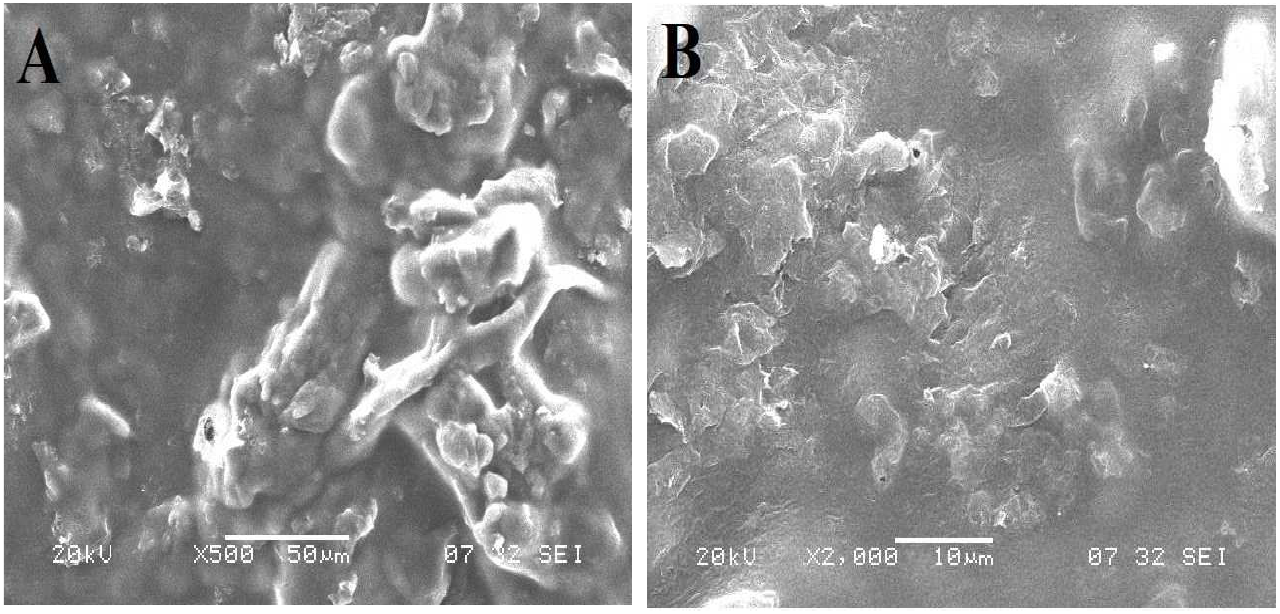
Figure 2. Scanning electron micrographs of ( A ) NTB (pure drug) at 500× magnification and ( B ) NTB– PEG solid dispersion at 2000× magnification.